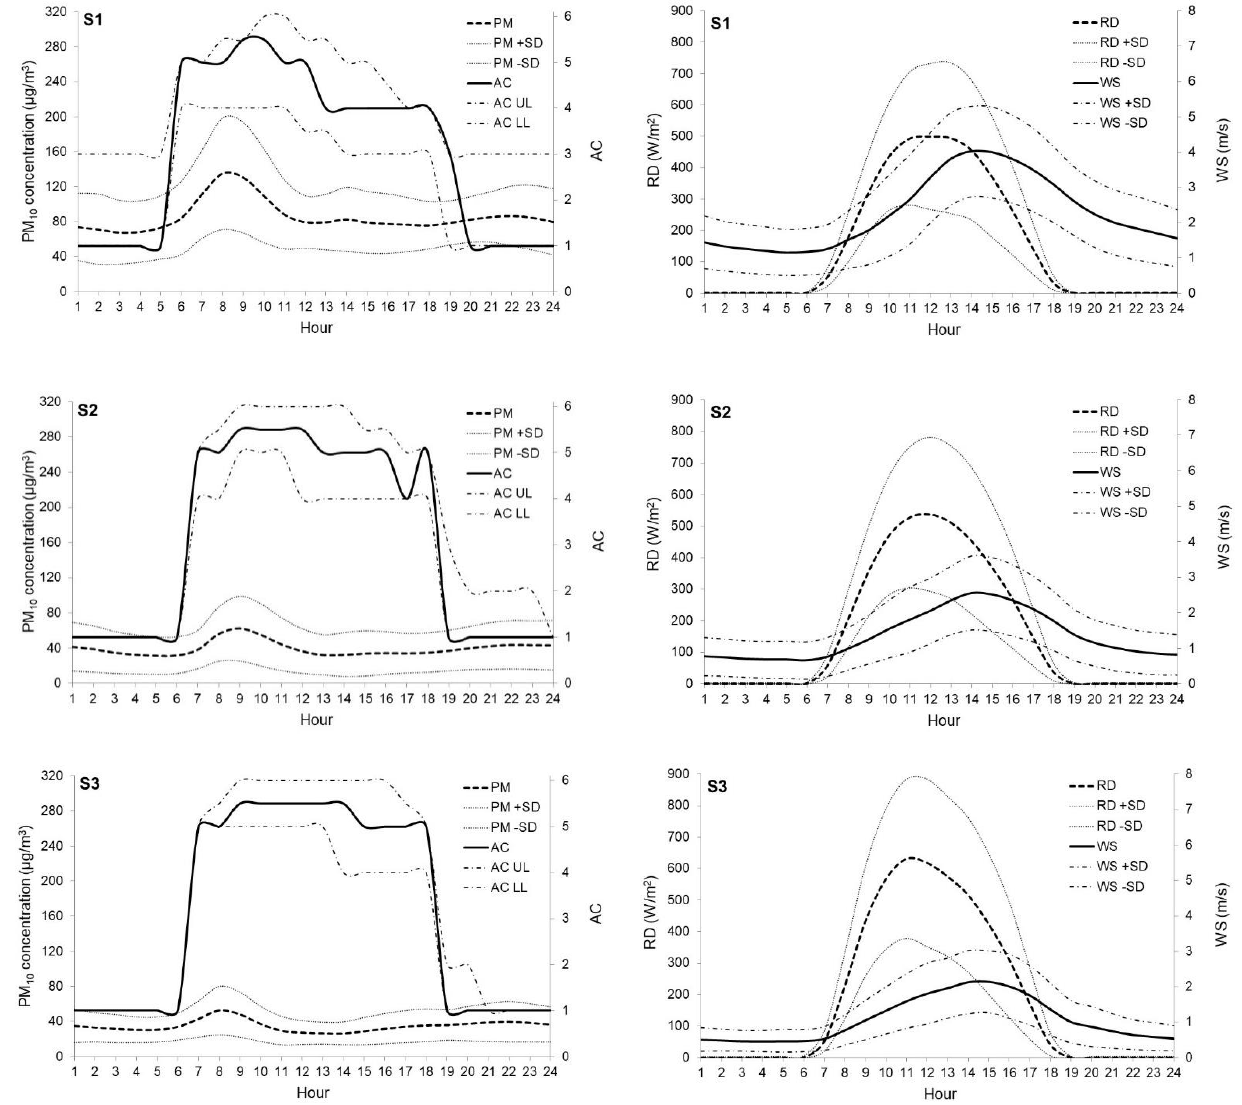
Figure 5. Average hourly of AC, RD, and WS during the whole research period. AC: 1 = stable, 2 = slightly stable, 3 = neutral, 3.5 = neutral to slightly unstable, 4 = slightly unstable, 4.5 = slightly unstable to unstable, 5 = unstable, 5.5 = unstable to very unstable, and 6 = very unstable. PM = average hourly PM 10 concentration. WS = wind speed. RD = solar radiation. SD = standard deviation. UL = upper limit. LL = lower limit.